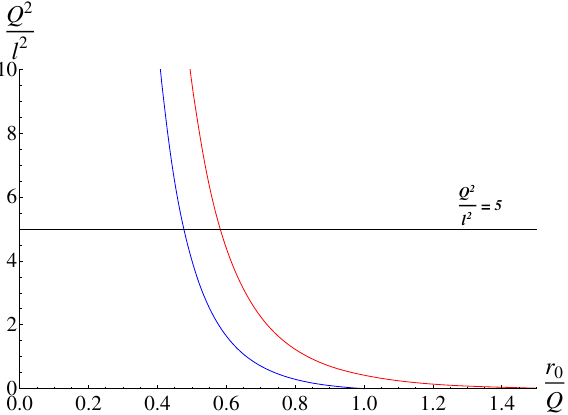
Fig. 3 Left:Weplotthereducedcosmologicalconstant Q 2 / l 2 interms ofthereducedextremalhorizonradius r 0 / Q .Right:Weplotthereduced mass M / Q of the extremal black hole in terms of the reduced extremal